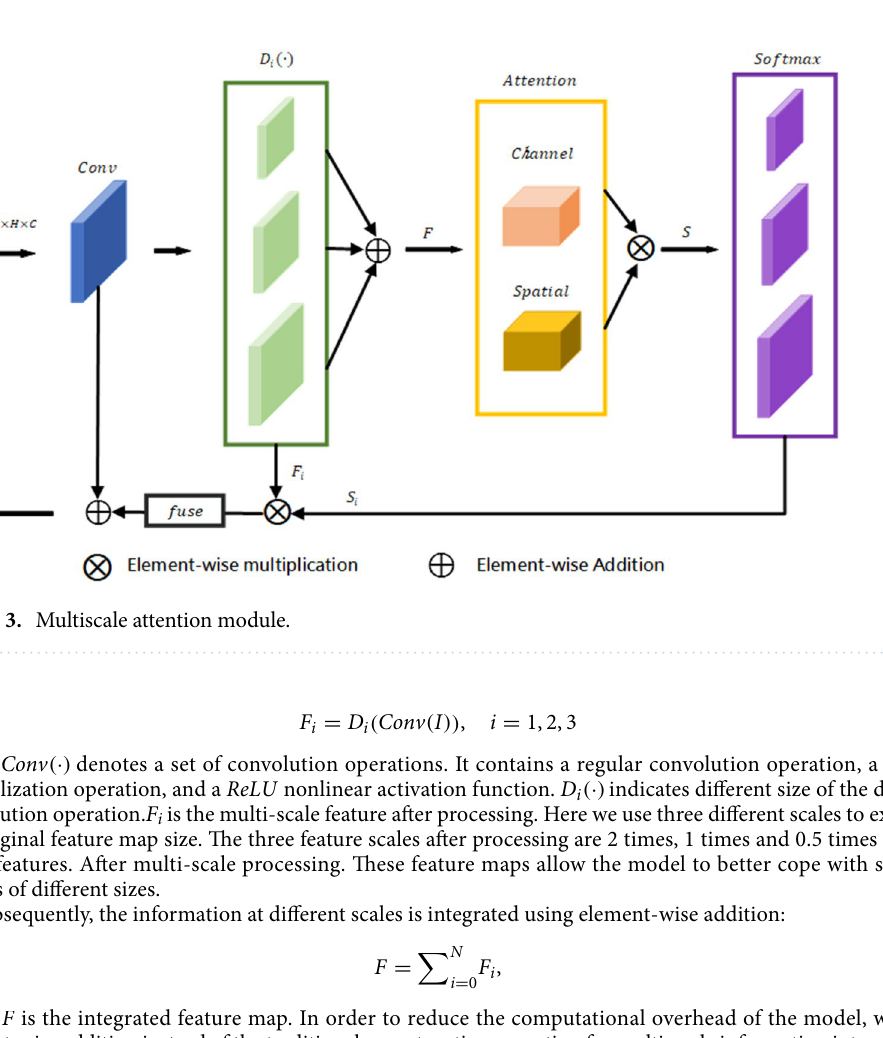
Figure 2. Architecture diagram of encoder.